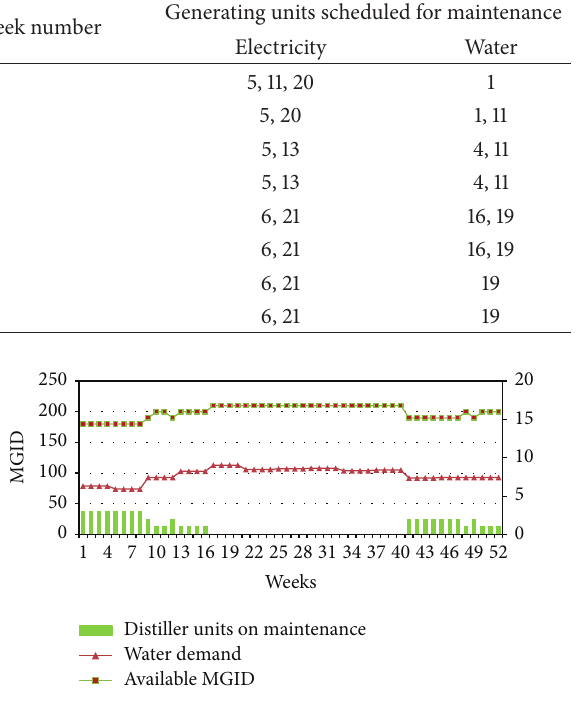
Figure 15: Distiller unit system output loads and gross reserves for 21 units with 20 percent increase in